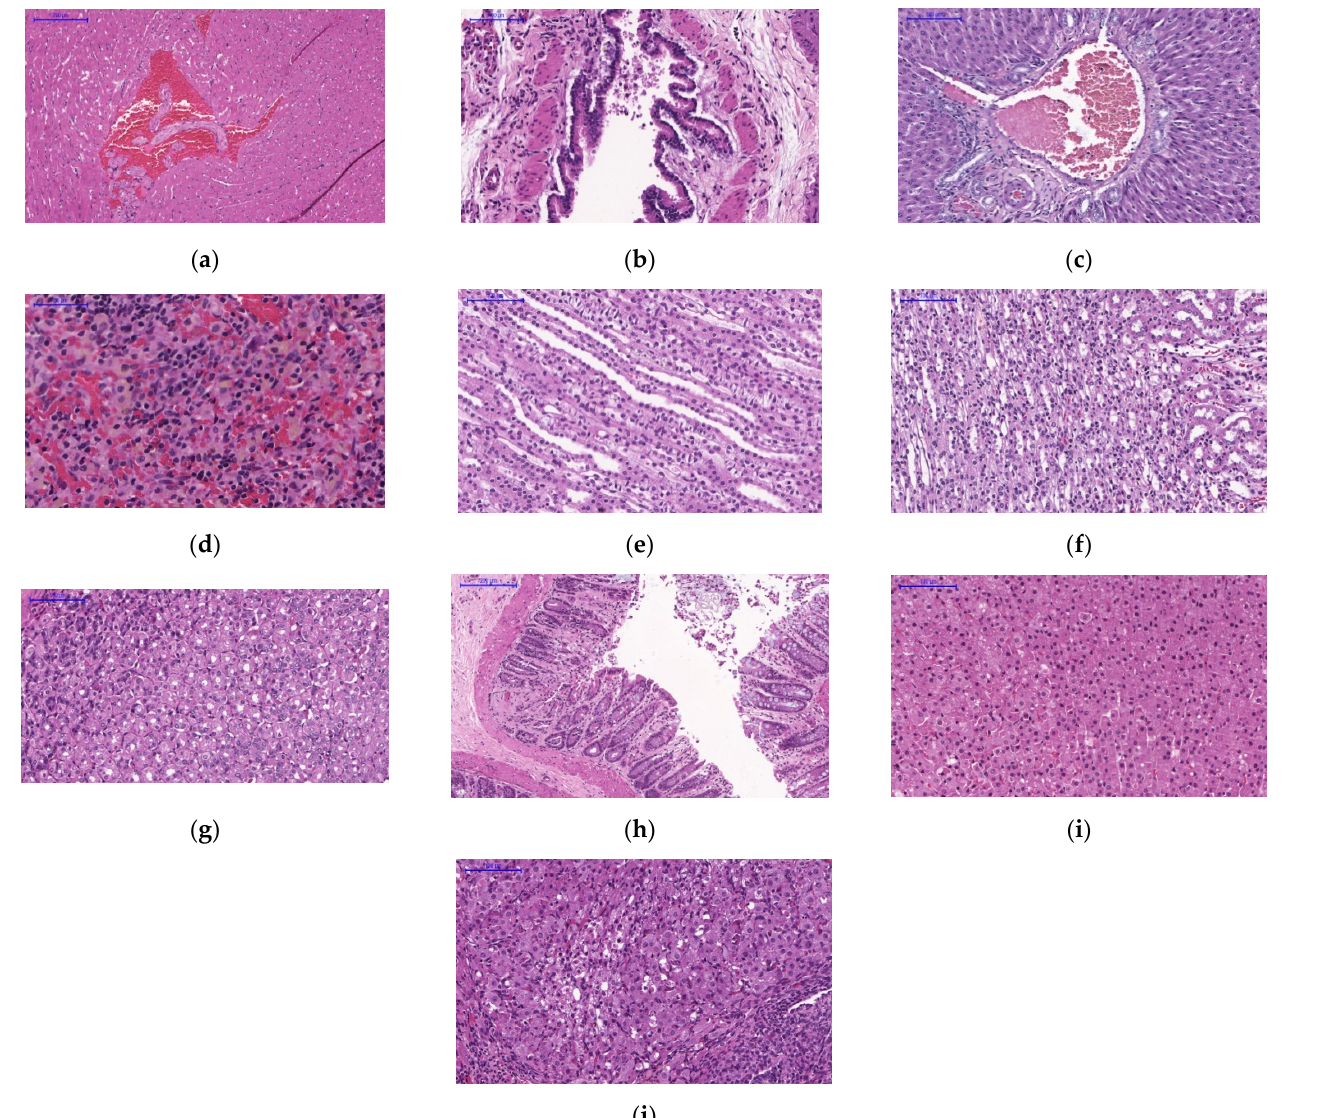
Figure 4. Histological specimens of rats’ tissues were collected after 28 days of treatment. Tissue samples were stained with haematoxylin and eosin. Representative histological pictures from the 2000 mg/kg dose groups were taken at the following magnifications: ( a ) heart (10×), ( b ) lung (20×), ( c ) liver (20×), ( d ) spleen (40×), ( e ) left side of kidney (10×), ( f ) right side of kidney (20×), ( g ) stomach (20×), ( h ) intestinal tract (10×), ( i ) left side of adrenal (20×) and ( j ) right side of ovary (40×).